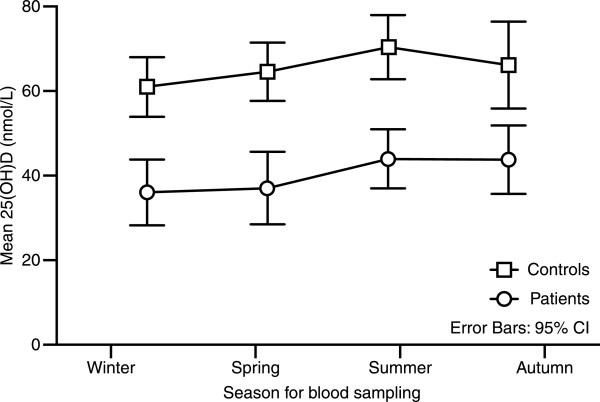
Serum 25(OH)D levels in relation to season.